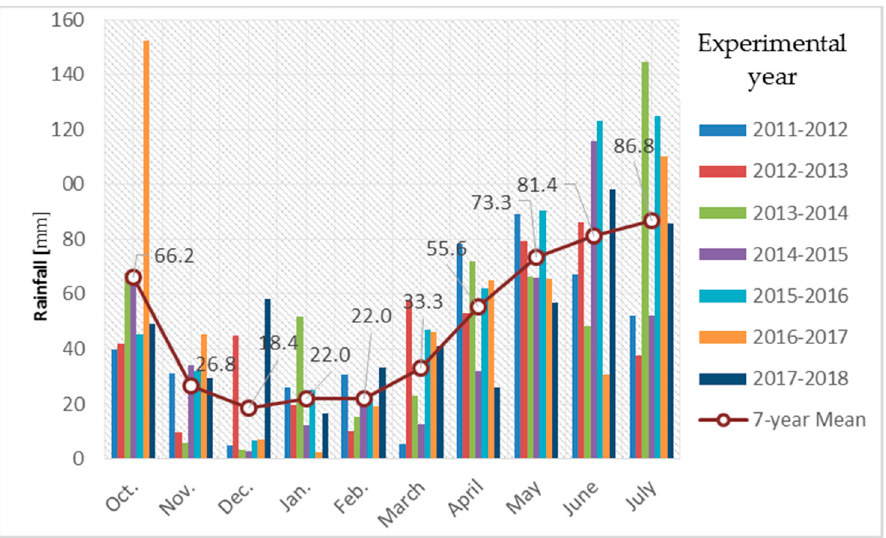
Figure 2. Total monthly rainfall for the seven vegetation seasons and the 7-year mean.